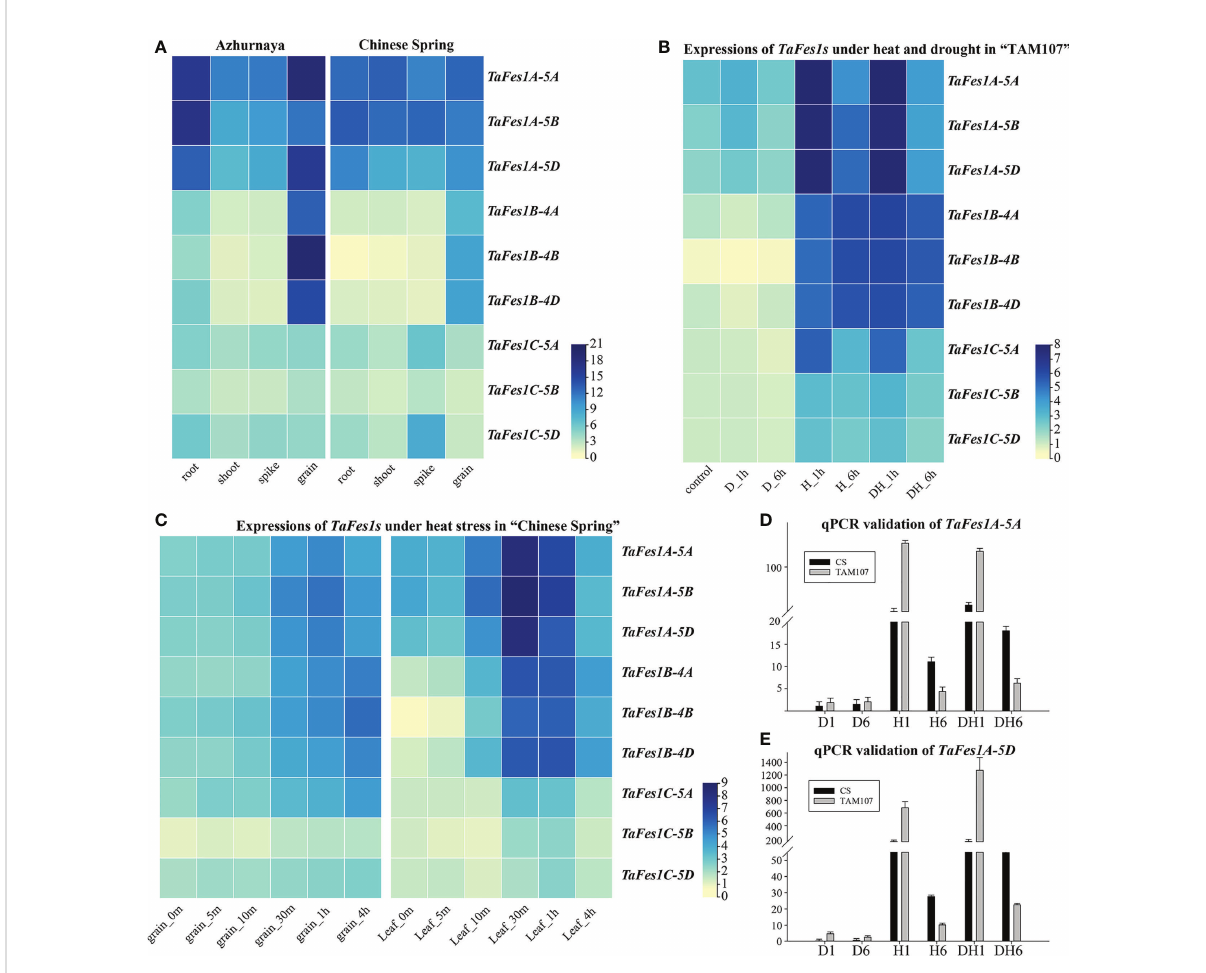
FIGURE 5 Expression pro fi les of TaFes1s in hexaploid wheat under normal and stress conditions. (A) Expression pro fi les of TaFes1s in wheat cultivar “ Azhurnaya ” and “ Chinese Spring ” , expression abundance is showed in tpm unit. (B) Expression pro fi les of TaFes1s in leaves of wheat cultivar “ TAM107 ” at seedlings stage under heat and drought conditions. Expression abundance is shown as log D_6h, drought stress for 6 hour, H_1h, heat stress for 1 hour, H_6h, heat stress for 6 hour, DH_1h, drought and heat stress for 1 hour, DH_6h, drought and heat stress for 6 hour. (C) Expression pro fi les of TaFes1s in wheat cultivar “ Chinese Spring ” at 15 days after anthesis under heat stress. Expression abundance is shown as log 2 tpm. The qPCR validation of TaFes1A-5A (D) and TaFes1A-5D (E) in wheat cultivar “ Chinese Spring ” and “ TAM107 ” under heat and drought stress, where the expression level is check by three independent biological replicates and shown as 2 - DD Ct . CS, Chinese